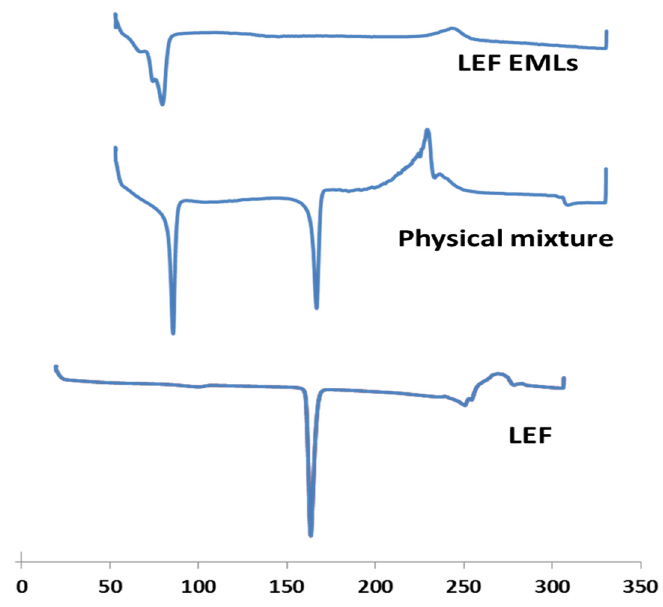
Figure 4. DSC spectra of LEF, LEF EMLs physical mixture, and selected EMLs formulation.